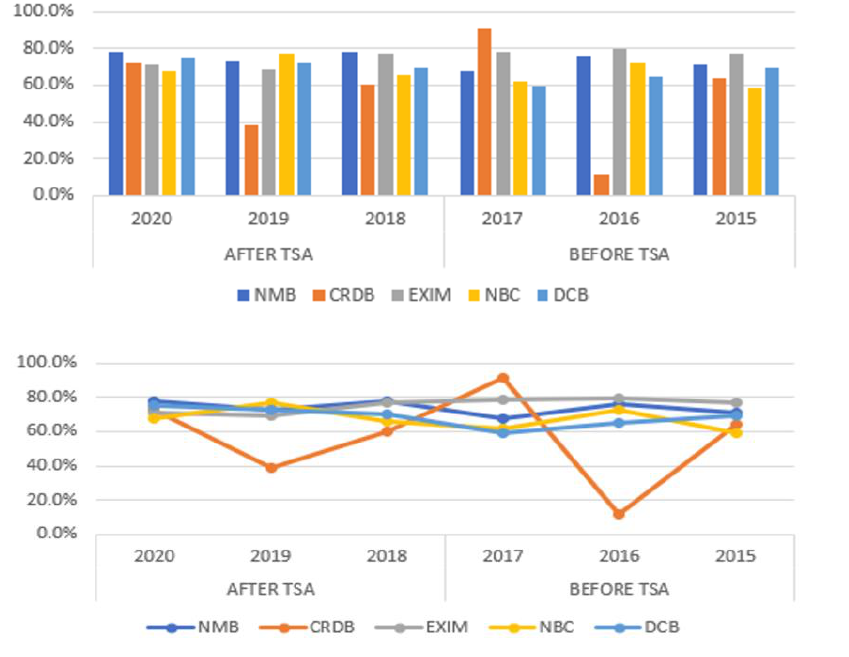
Figure 5: Liquidity position (Loan-to-Deposit Ratio); Source: Author’s Compilation, 2021